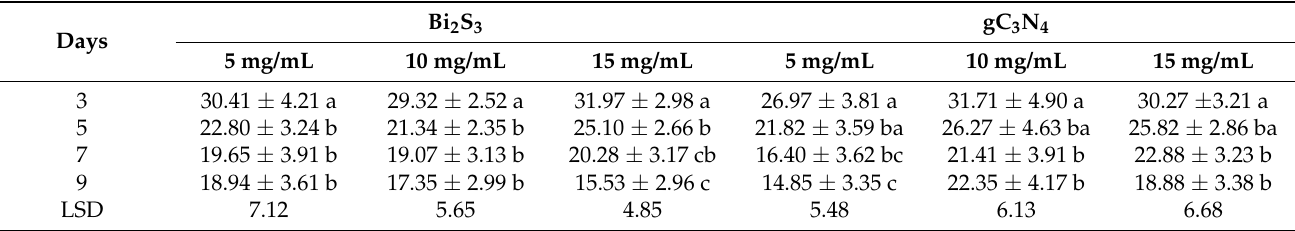
Table 4. Effects of experimental duration (days) on the nanoparticle inhibition of fungi.